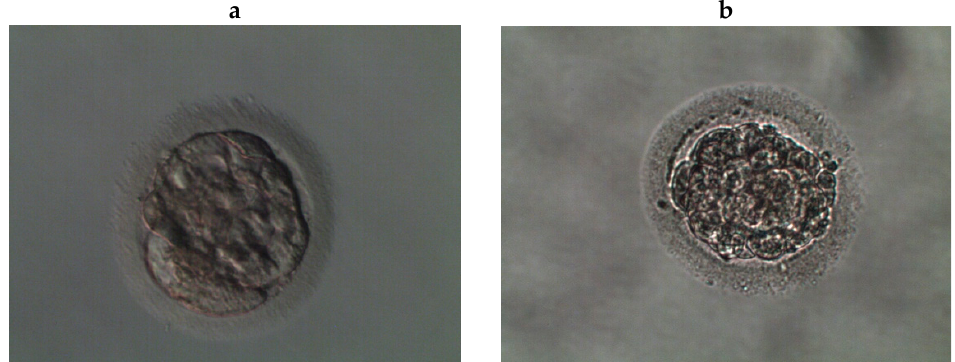
Figure 1. Image of the single day 5, grade 3AA blastocyst post-thaw ( a ) and pre-transfer ( b ).